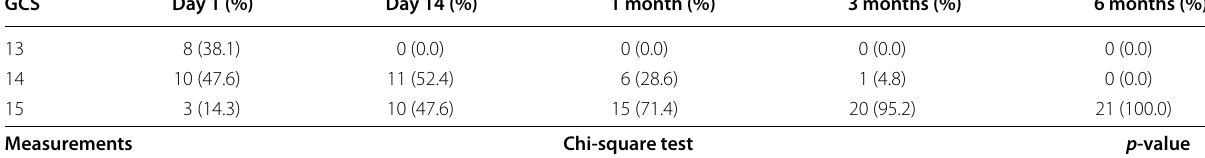
Table 6 A GCS values for patient with a favorable neurological outcome ( n